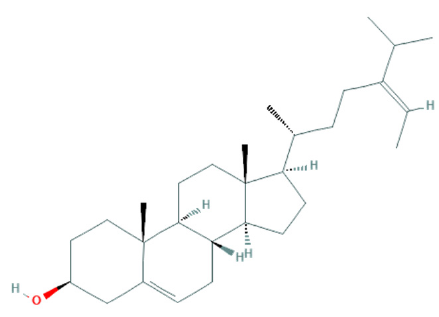
Figure 1. Fucosterol (C 29 H 48 O). Chemical structure obtained from PubChem database on 4 August 2021 (https://pubchem.ncbi.nlm.nih.gov/compound/5281328#section=2D-structure).